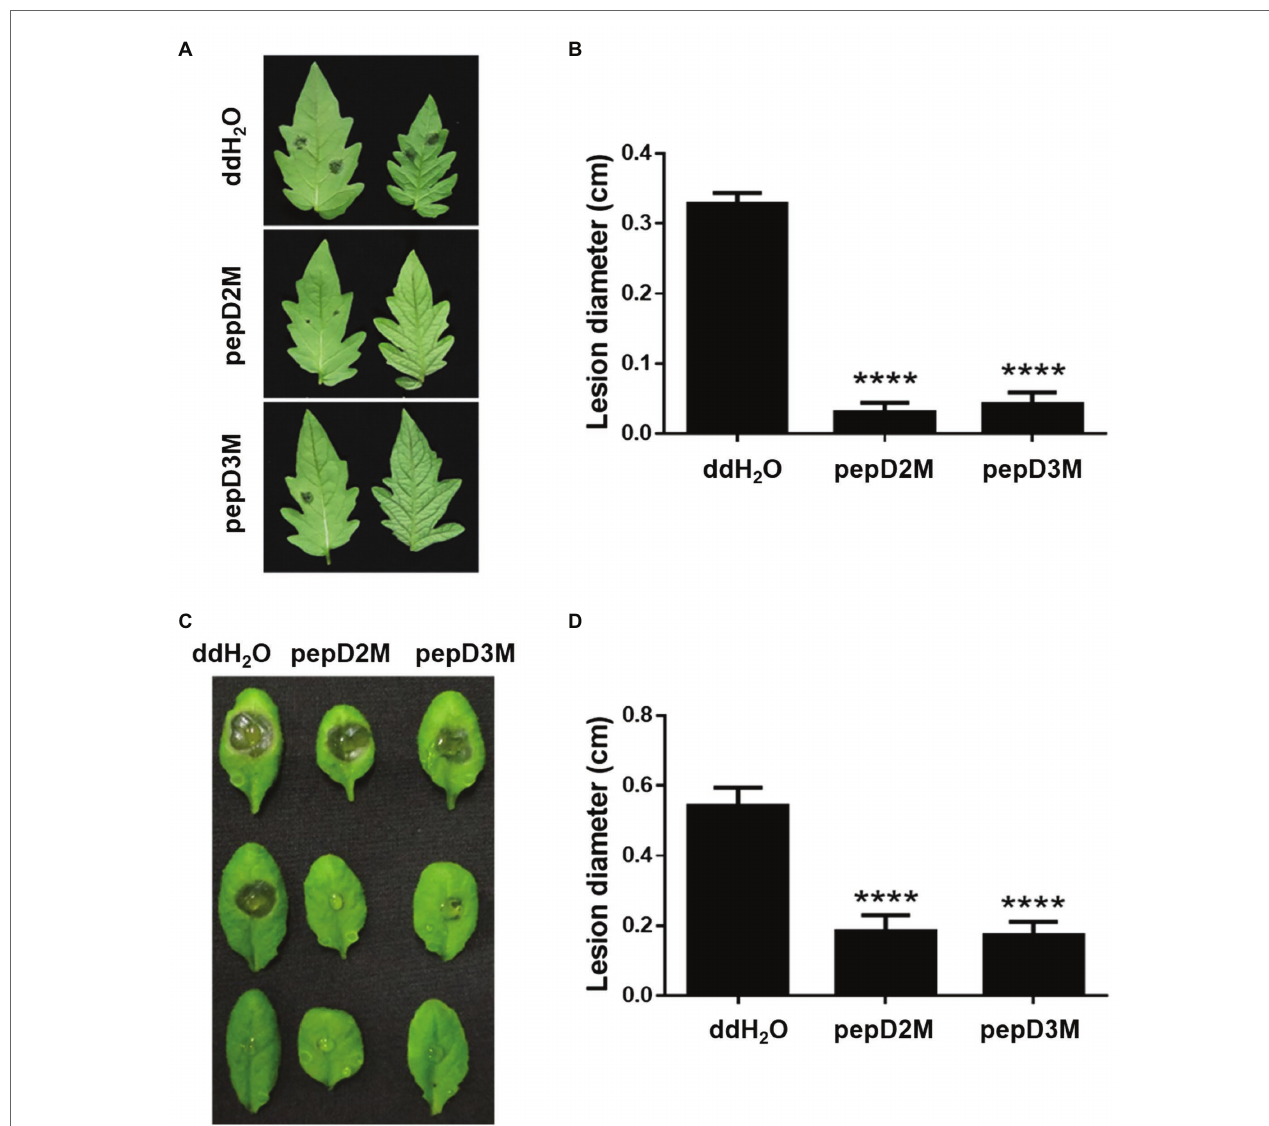
FIGURE 7 | Effects of pepD2M and pepD3M on the plant responses after the infection with Botrytis cinerea ( Bc ). The Bc spore suspension (10 4 spores/ml for the tomato inoculation and 10 5 spores/ml for the Arabidopsis inoculation) was mixed with the indicated peptide (64 μ g/ml) at a 3:1 ratio to produce a final peptide concentration of 16 μ g/ml. Crude peptides that were not purified via HPLC were used. Detached leaves of 4-week-old tomato L390 plants (A,B) and leaves of the intact Arabidopsis Col0 plants (C,D) were wounded with a 10 μ l micropipette tip and then droplet inoculated with 10 μ l of the Bc -peptide mixture. The disease symptoms were photographed 47–70 h post-inoculation (A,C) , after which the diameters of the lesions were measured (B,D) . The data are from a single experiment that was repeated at least three times with similar results. (B,D) The values are the average ± SE (n ≥ 30). Pair-wise comparisons of the water- and peptide-treated samples were made using the Student’s t -test (**** p <